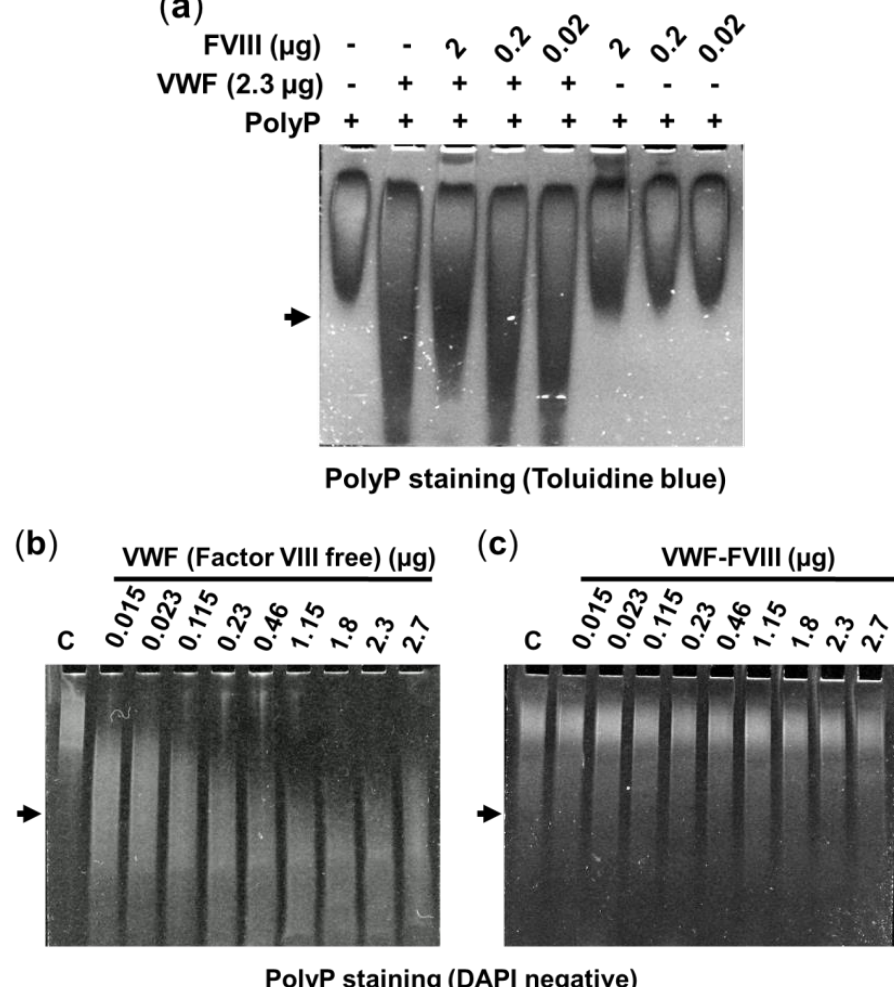
Figure 2. Characterization of the polyphosphate-von Willebrand Factor binding, in the absence or presence of factor VIII, using urea–polyacrylamide gel electrophoresis. ( a ) Purified von Willebrand factor (factor VIII-free, 2.3 µg) and/or purified factor VIII (0.02 to 2 µg) were incubated with 0.8 mM of isolated polyphosphate (polyP 65 ). Samples were loaded onto urea–polyacrylamide gels, separated by electrophoresis, and stained using a polyphosphate-specific staining (toluidine blue). Arrows show the mobility of von Willebrand factor on the gels. Representative experiments are shown (n = 3). ( b , c ) Increasing amounts of von Willebrand factor, either factor VIII-free in ( b ), or von Willebrand factor co-purified with factor VIII in ( c ), were incubated with 0.8 mM of isolated polyphosphate (polyP 65 ) as described in Methods. Samples were separated as before and stained using a sensitive polyphosphate-specific staining (DAPI negative). Similar experiments, but stained with toluidine blue, are shown in Supplementary Figure S1.